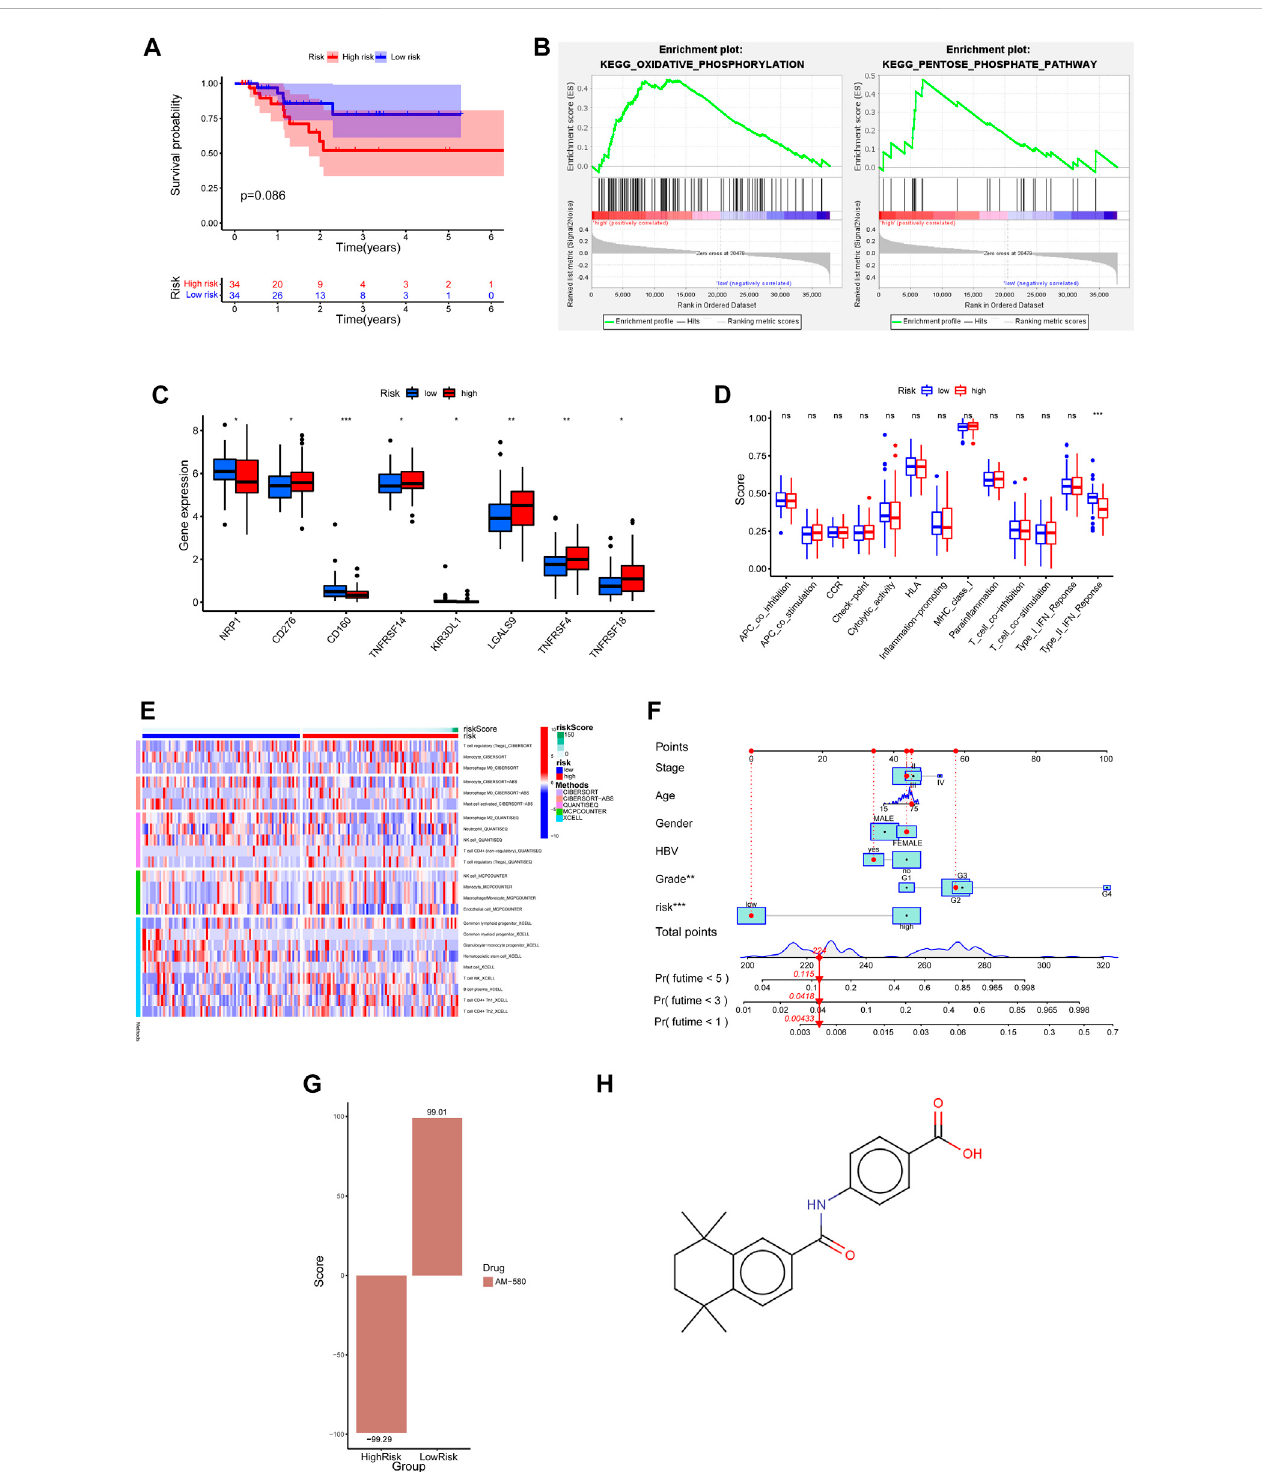
FIGURE 6 Clinical predictiveapplicationofbiologicaldifferences andprognostic riskmodelsinhigh andlow risk groups. (A) Prognostic risk modelof Kaplan-Meier survival curve in HCC patients with TP53 mutant. (B) GSEA enrichment analysis showed that pathways were signi fi cantly associated with high risk scores. (C) Differential expression of common immune checkpoints between high and low risk groups. (D) The difference of immune-related function in high and low riskgroups. (E) Basedon fi vealgorithms,thedifferencesinimmunecellin fi ltrationbetweenhighandlowriskgroupswereevaluated. (F) Nomographwas used to predict 1-year, 3-year and 5-year OS in patients with TP53 wild type HCC. (G) The correlation between the differentially expressed genes in high and low risk groups and the expression pro fi le of AM580. (H) The molecular structural formula of